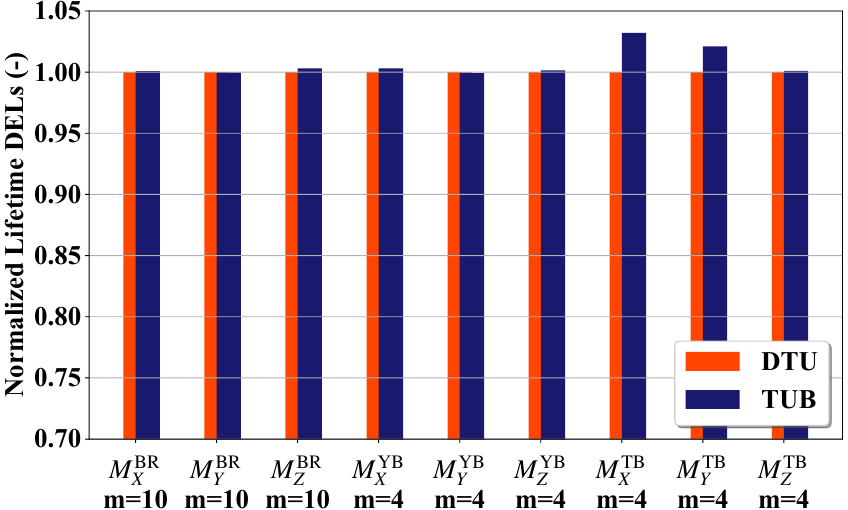
Figure 10. Normalized lifetime Damage Equivalent Loads (DELs) for considered sensors. Nomencla- ture is found in Table